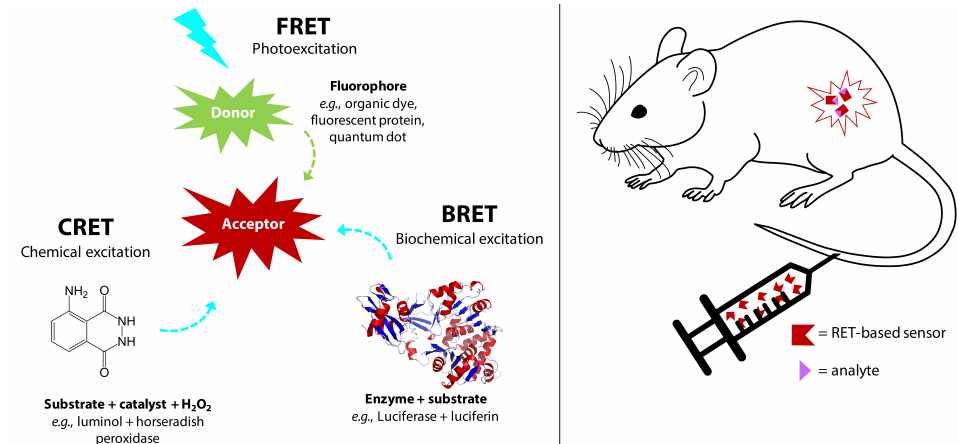
Figure 1. Schematic illustration of FRET, BRET and CRET-based systems, which can be injected in mice for RET-based imaging and biosensing. FRET, BRET, and CRET exploit the non-radiative energy transfer from an excited donor to an acceptor molecule in the ground-state when they are in close proximity, typically 1–10 nm. In FRET, the donor excited state occurs through external optical excitation, whereas in BRET and CRET, the donor is excited through a biochemical or chemical reaction that generates bioluminescence or chemiluminescence,